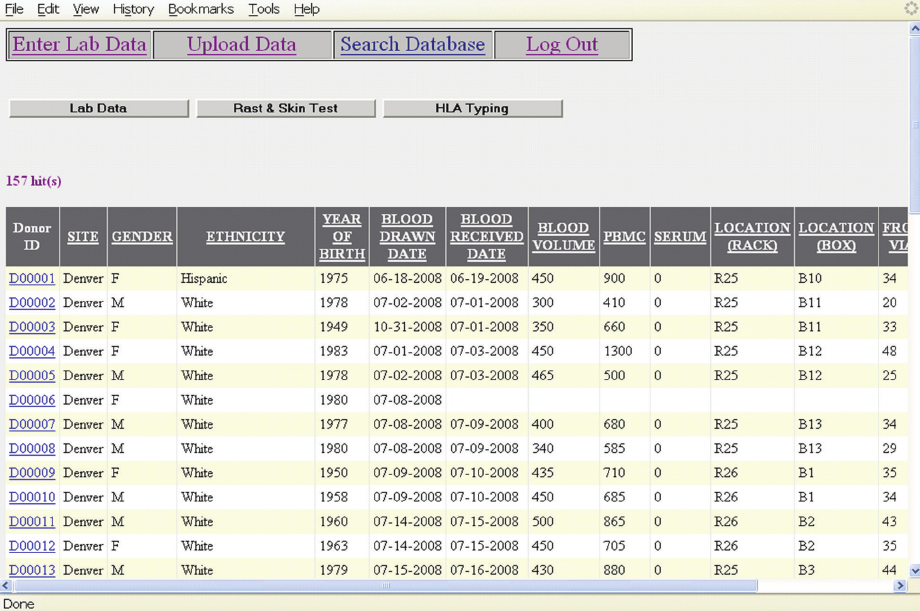
Figure 4: DONORDB: search functionality. The Figure shows a screen shot of the results generated when querying for all enrolled donors.